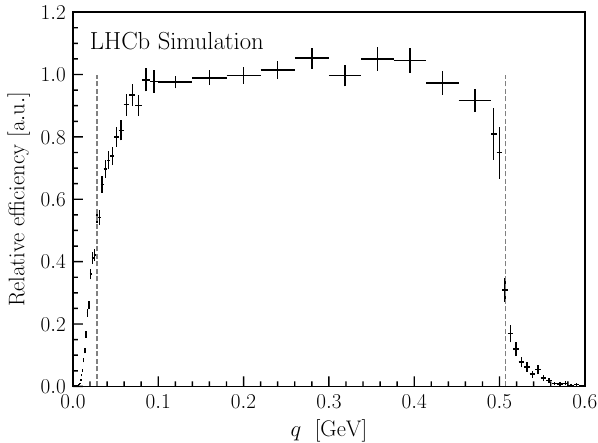
Figure 1 . Relative efficiency as a function of the dielectron invariant mass ( q ). The points represent the efficiency obtained from simulation, while the vertical lines represent the effective q 2 boundary defined in the